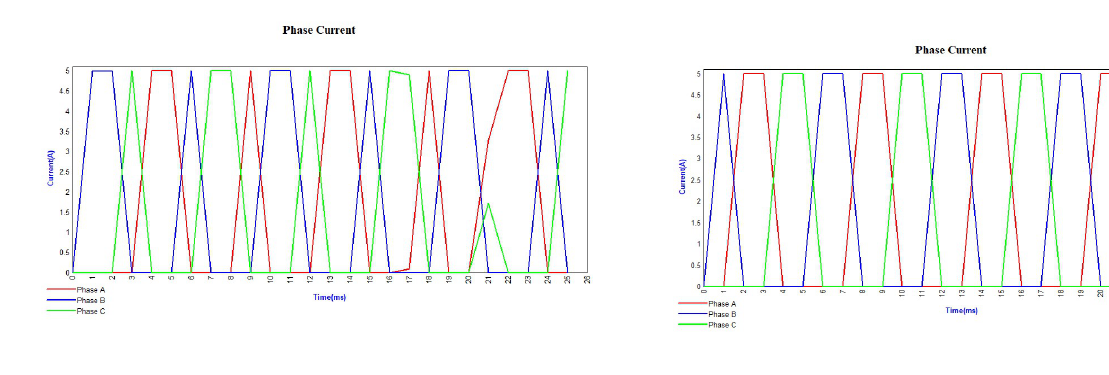
Fig. 7. 8/6 SRM Phase Current.